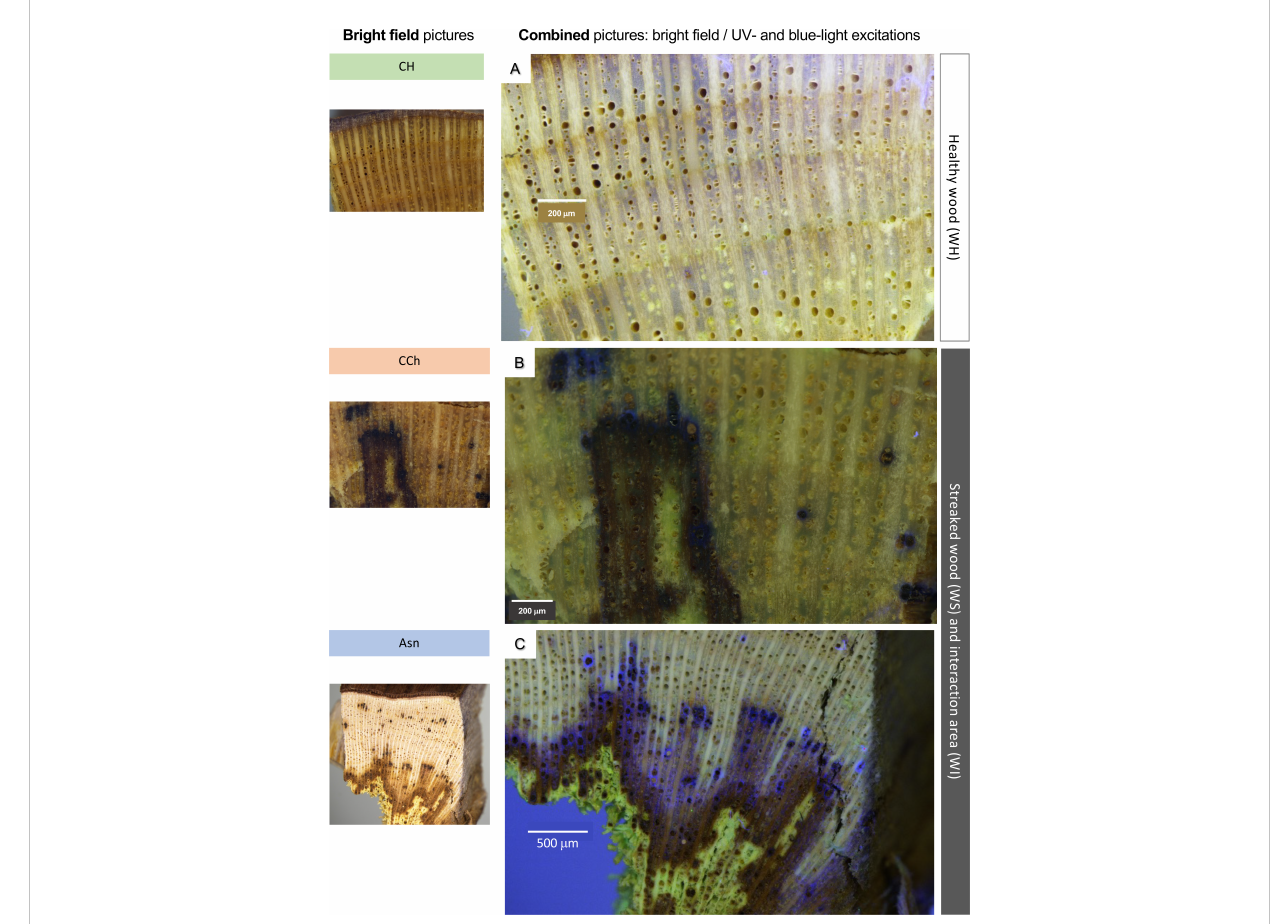
FIGURE 5 Observations, in bright- fi eld (left pictures) and/or fl uorescence microscopy (A – C) , of samples of woody tissues, collected on CH, CCh, or Asn vines, in healthy (WH) or interaction area (transition healthy/brown necrotic wood; WI). Bar: 200 m m (A, B) or 500 m m (C) .